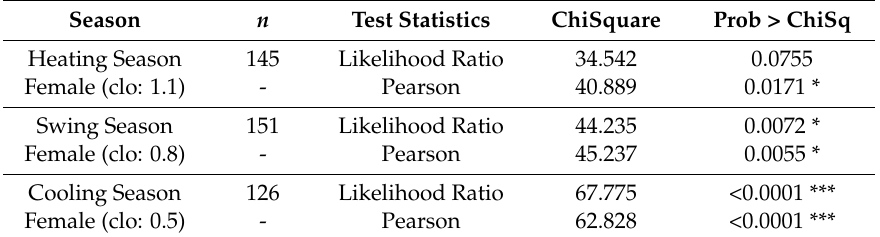
Figure 6. User satisfactions on air temperature for female occupants by size of zone by season (clo). Table 10. Contingency Analysis of User Satisfaction on Temperature by Size of Zone,